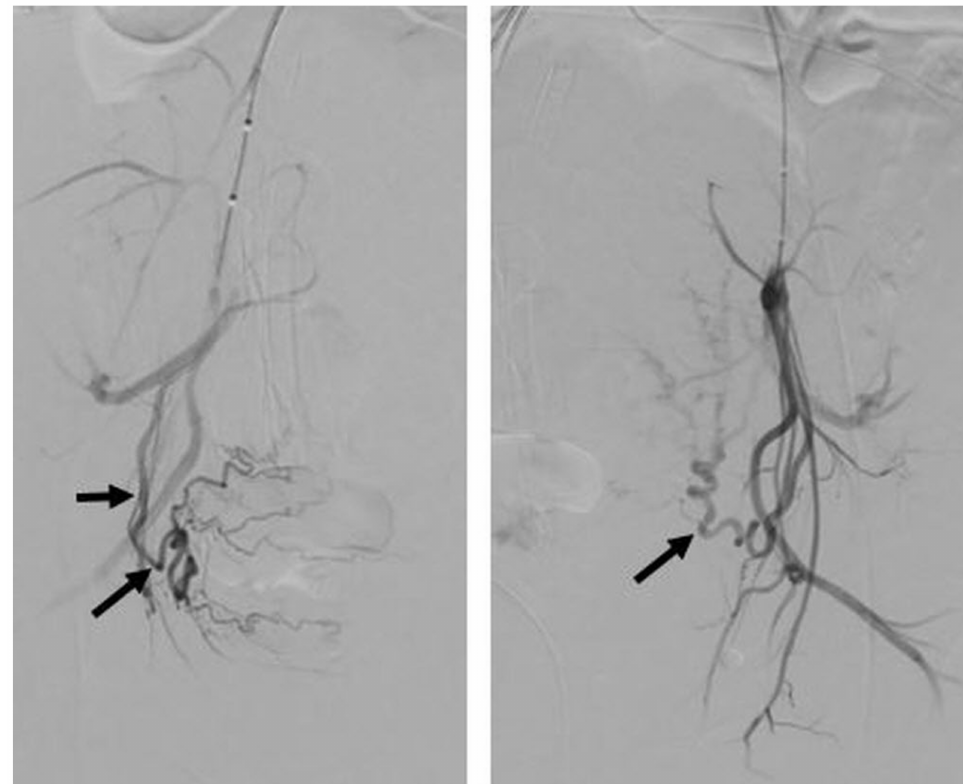
Figure 3. Pelvic angiogram after operation of a 40-year-old woman shows hypertrophied bilateral uterine arteries (arrows) without evidence of contrast extravasation, arteriovenous malformation or abnormal hypervascular lesion. Proper hemostasis was achieved within the operation field, and vital signs were also stable for this patient; hence, the balloon catheter was removed without an additional